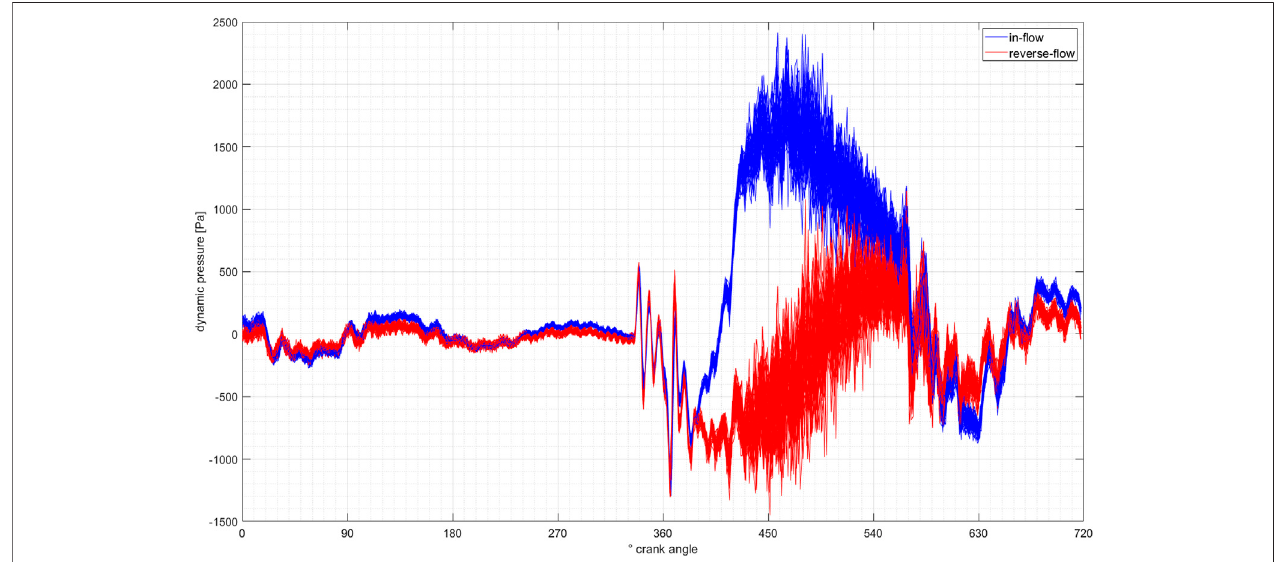
FIGURE 5 | The dynamic and static pressure in the intake duct for one engine cycle at an engine speed of 1,200 rpm in natural aspirated mode.